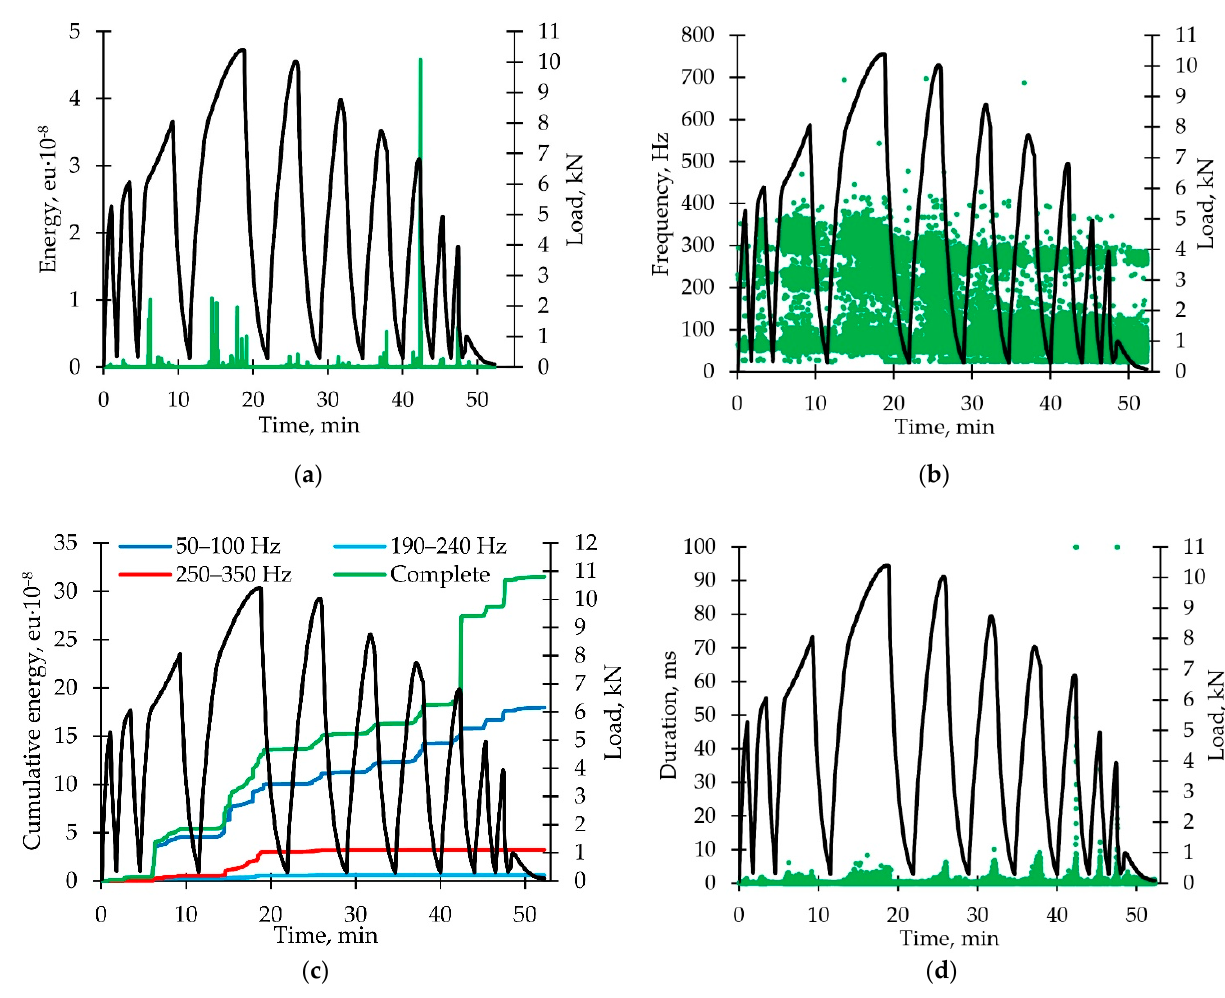
Figure 9. Acoustic emission signals analysis (loading with unloadings): ( a ) Typical distribution diagram of AE signal energy parameter versus time; ( b ) typical distribution diagram of AE signal frequency parameter versus time; ( c ) typical diagram of cumulative energy dependence on time for various AE signal frequencies; ( d ) typical distribution diagram of AE signal durability parameter versus time. All the diagrams are shown with load dependence on time.